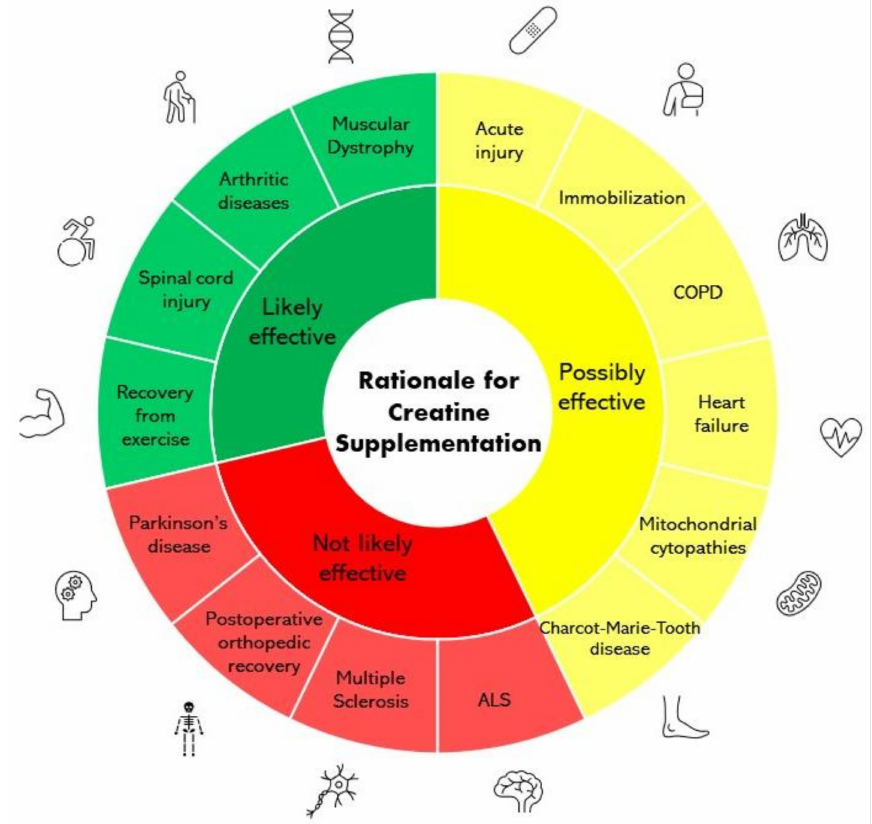
Figure 1. Rationale for examination of creatine supplementation as a rehabilitative aid. Abbreviations defined from clockwise: COPD = chronic obstructive pulmonary disease; ALS = amyotrophic lateral